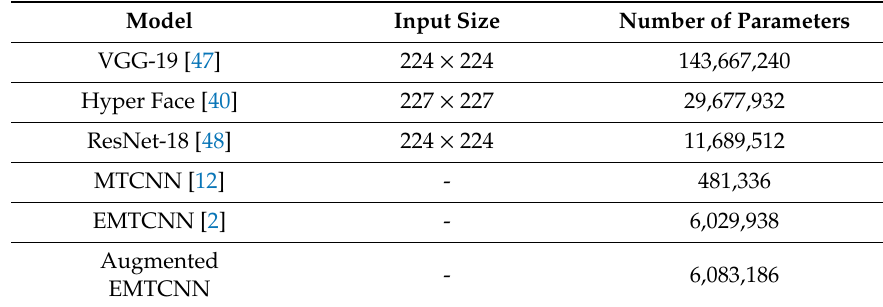
Table 1. Comparison of the number of parameters.